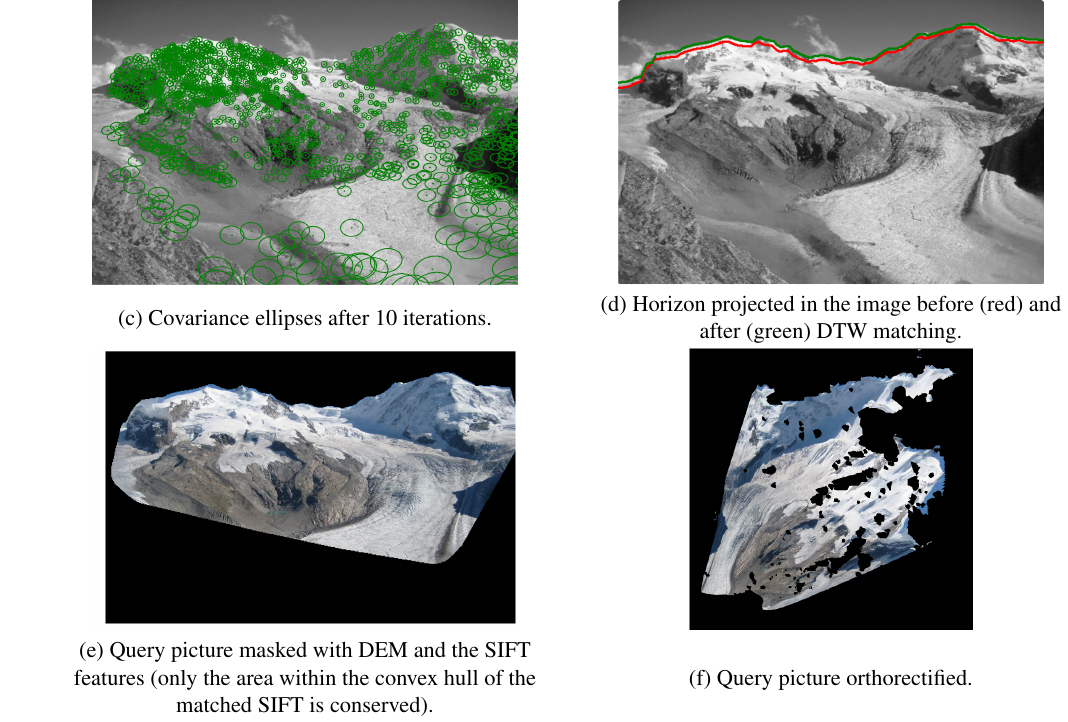
Figure 4: Representation of the query images pose estimation